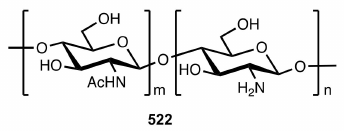
Figure 39. The structure of the